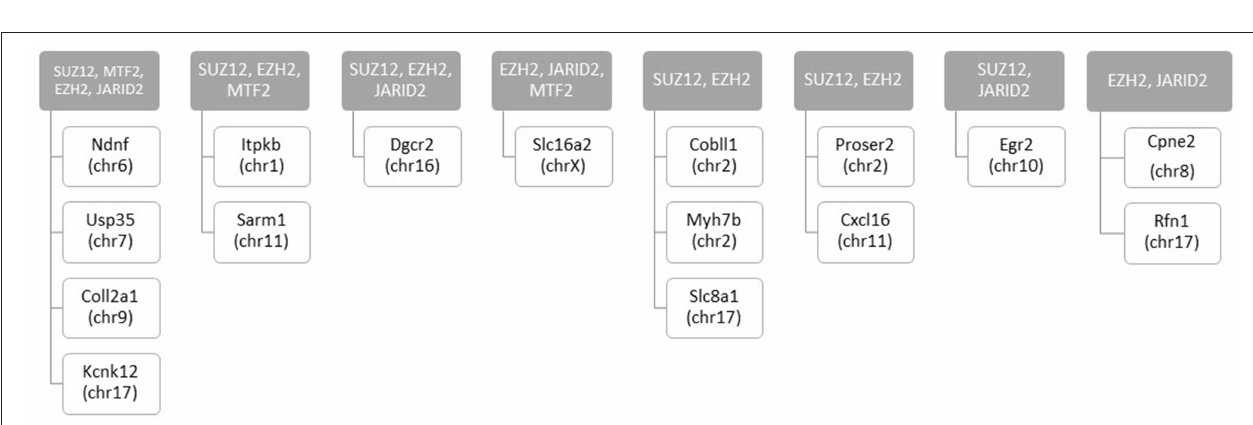
FIGURE 4 | DMRs of PcG binding sites in continuous exposure group are predominantly hypermethylated. RRBS analysis of effector memory CD4 + T cells from control and continuous TCE exposure. (A) Regulatory elements included in the ORegAnno database were assessed. The number of hypermethylated vs. hypomethylated DMRs for each PcG protein binding region are shown. (B) Represents a summary of the few hypomethylated regions according to gene and chromosome location.